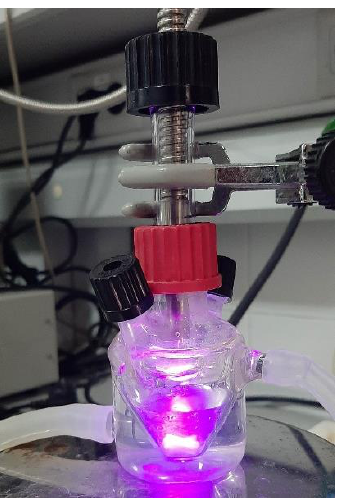
Figure 2. Picture of the photocatalytic reactor used in the hydrogen production from glycerol